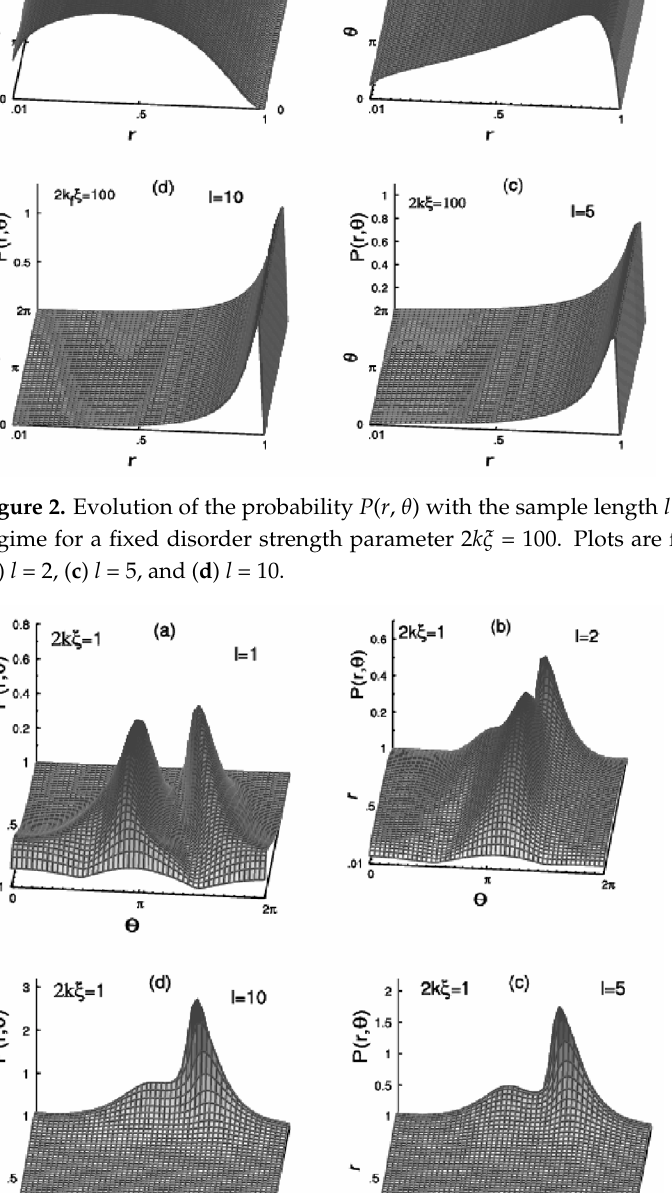
Figure 3. Evolution of the probability P ( r , θ ) with the sample length l (= L / ξ ) in the medium/intermediate disorder regime for a fixed disorder strength parameter 2 k ξ = 1. Plots are for sample lengths: ( a ) l = 1, ( b ) l = 2, ( c ) l = 5, and ( d ) l = 10.